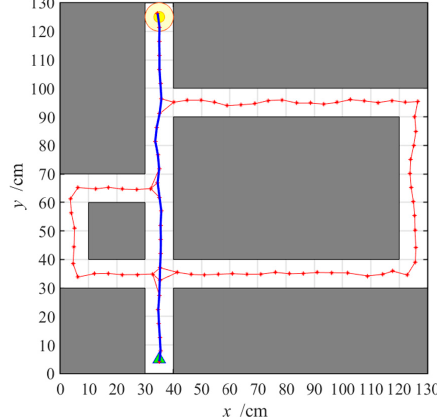
Figure 7. Navigation path with the hippocampal model alone. Red asterisks and the red lines linking